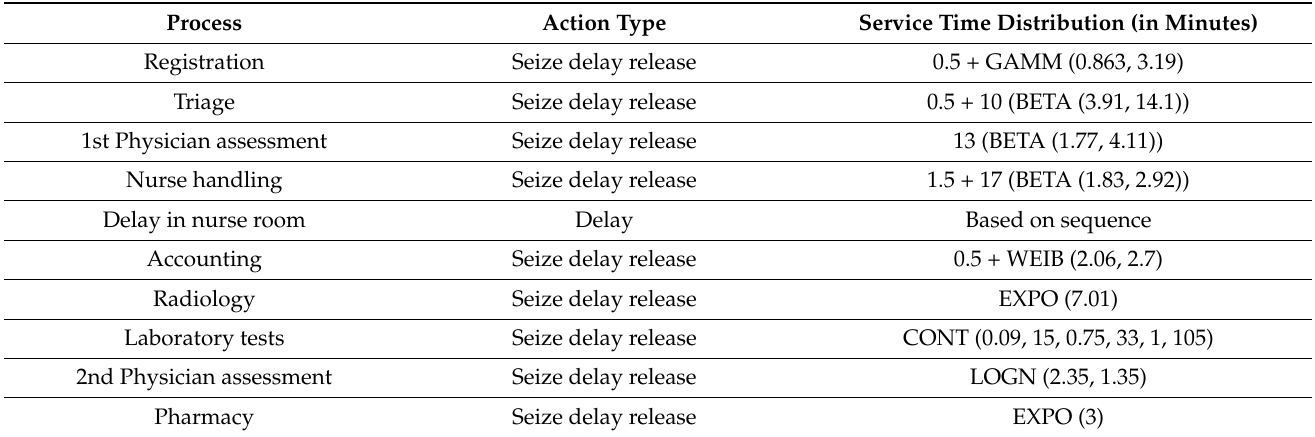
Table 5. Processes with their action type and service time distribution.